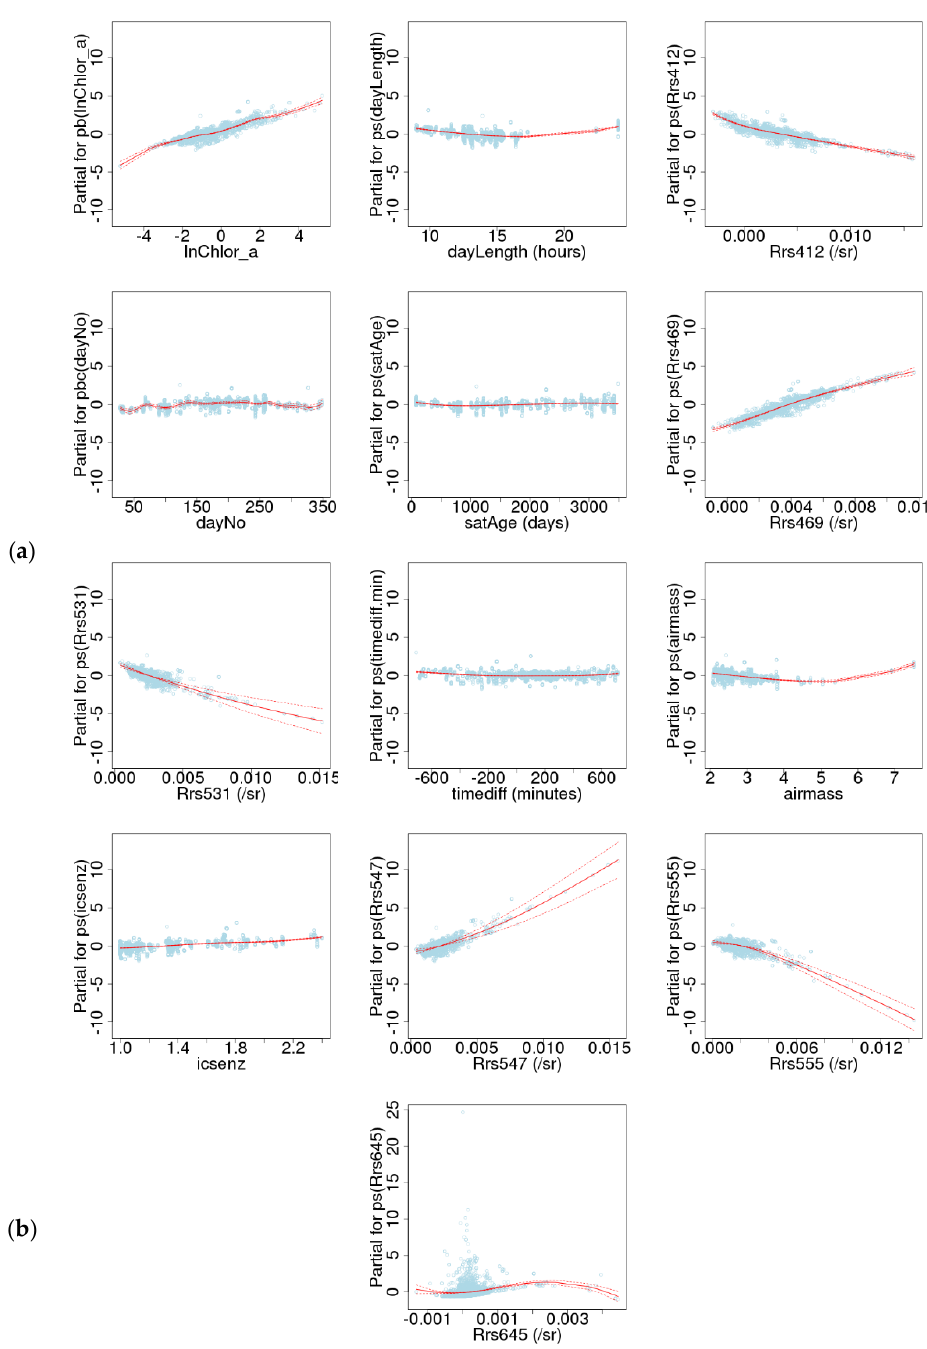
Figure 3. Dependencies of the best fitting model. Each graph shows the dependency of a model parameter (mean or standard deviation) on a single explanatory variable (the ‘partial dependency’), all others being held constant. The red line is the model prediction, the pink lines are one standard error either side of this, and the pale blue circles are the prediction plus the model residual at each data point. ( a ) Mean model dependencies, in the order that they were added by gamlss: (top row) pb(ln(chlSAT)), ps(day length), and ps( R rs (412)); (second row) pbc(day of year), ps(satellite age), and ps( R rs (469)); (third row) ps( R rs (531)), ps(time difference), ps(airmass); (bottom row) ps(1/cos(view zenith angle)), ps( R rs (547)), and ps( R rs (555)). All graphs have the same scale on the vertical axis. ( b ) Dependency of ln(standard deviation) on ps( R rs (645)).